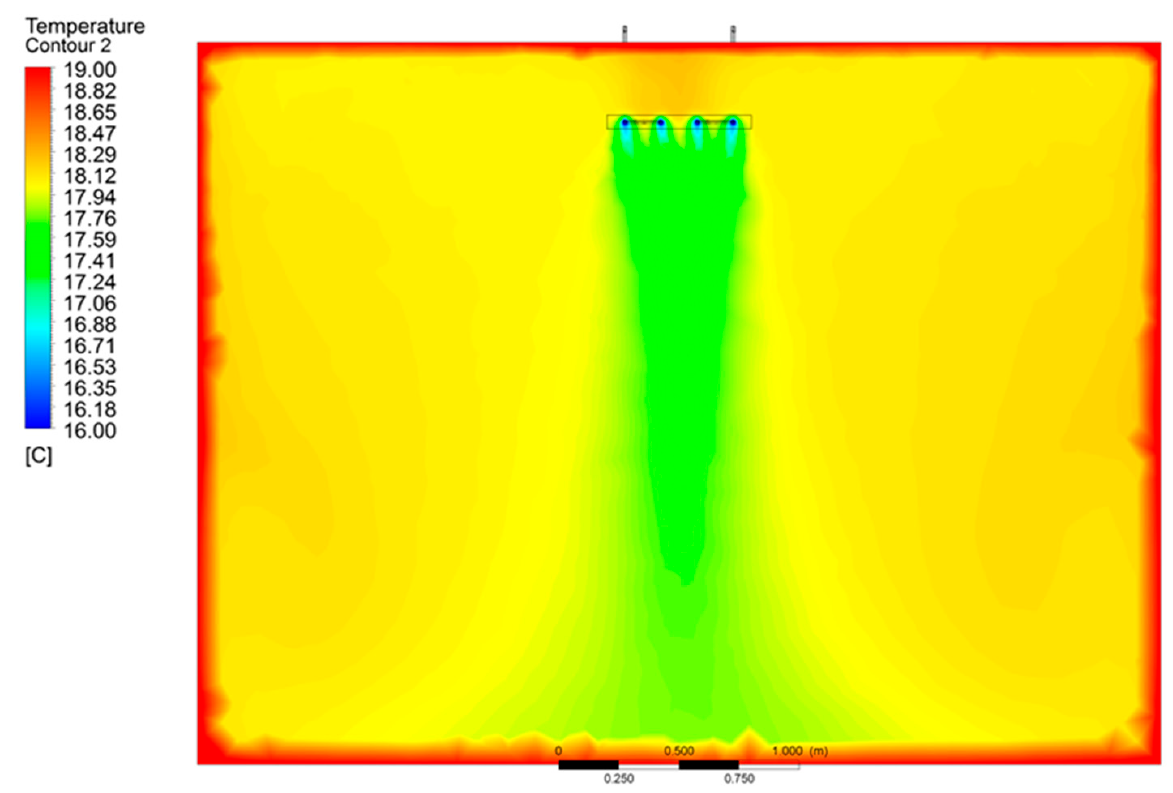
Figure 21. Model of passive cooling beam—the contours of temperature (°C).